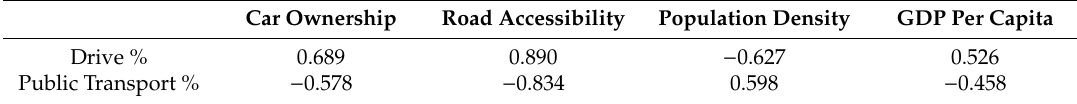
Table 2. Normalized correlation coe ffi cients between travel mode choices and urban indicators.